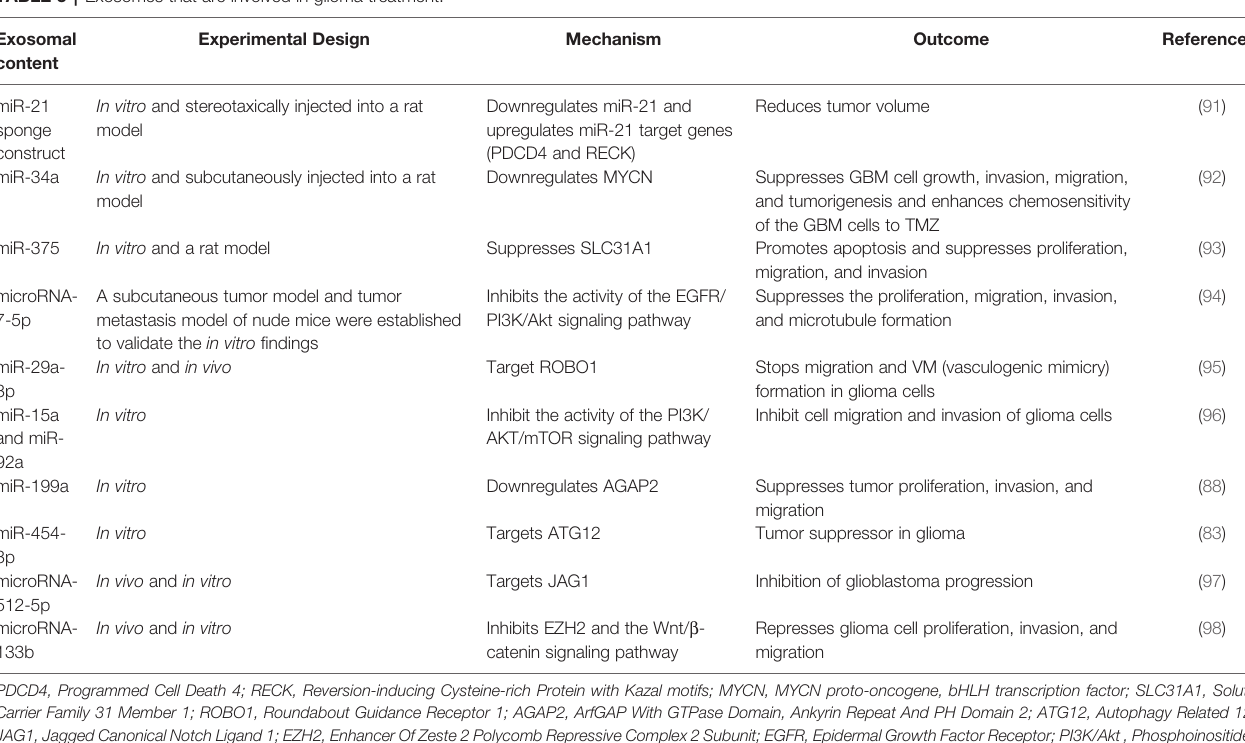
TABLE 3 | Exosomes that are involved in glioma treatment.